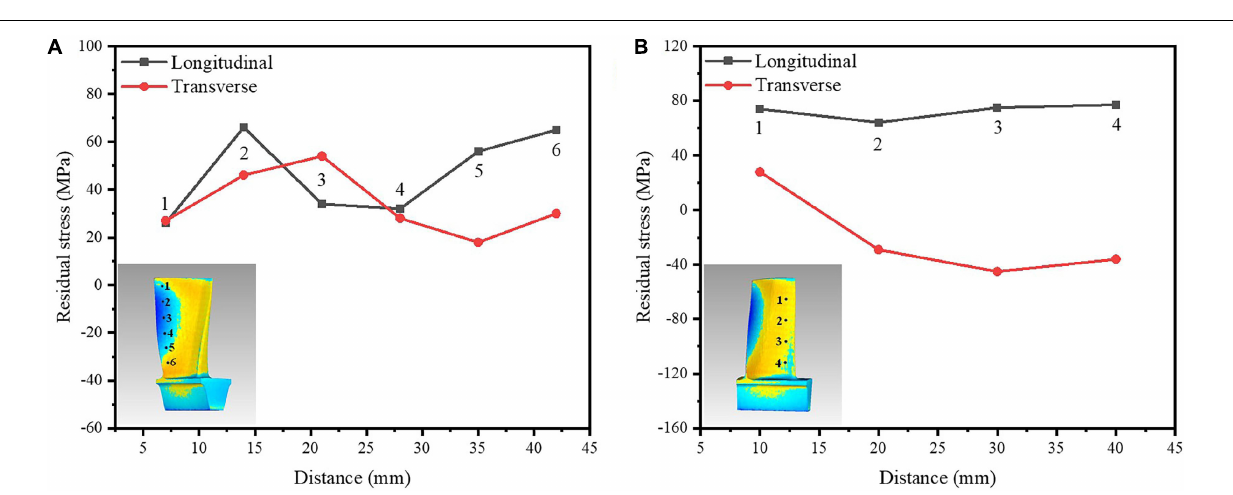
with the distribution of thermal stress by the simulation in Figure 12 . The surface residual stress of the blade is tensile stress at the edge and compressive stress inside the blade body,